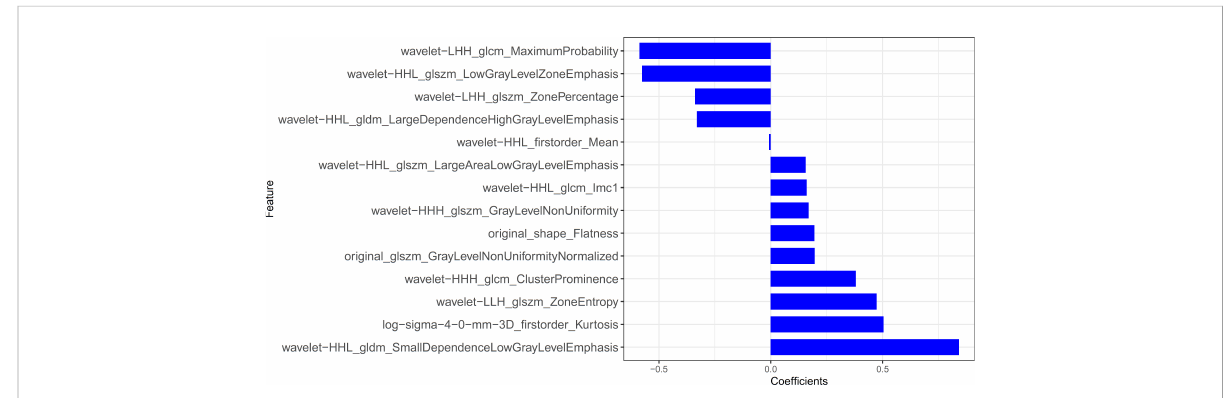
FIGURE 4 The histogram of the Rad-score: the y-axis indicates the selected fourteen radiomics, and the x-axis represents the coef fi cient of